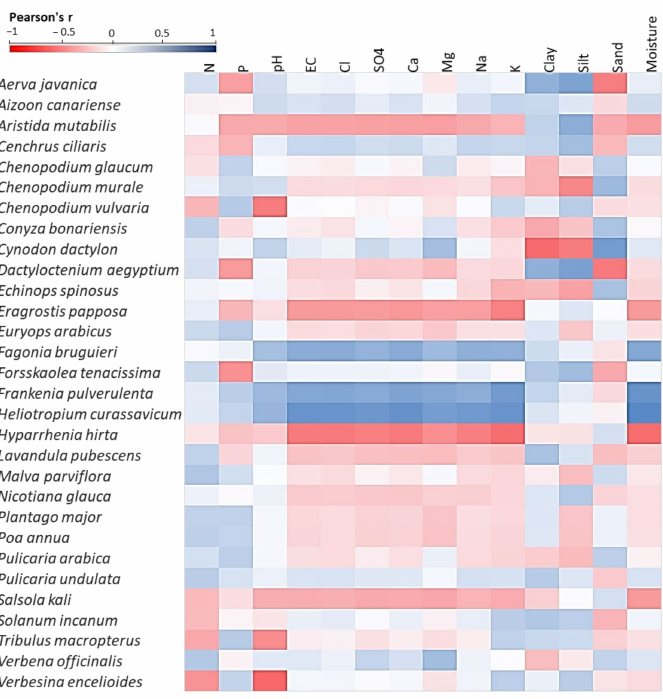
Figure 8. Pearson’s correlation heatmap between the soil variables and the dominant and important species represented in the studied locations invaded with Nicotiana glauca